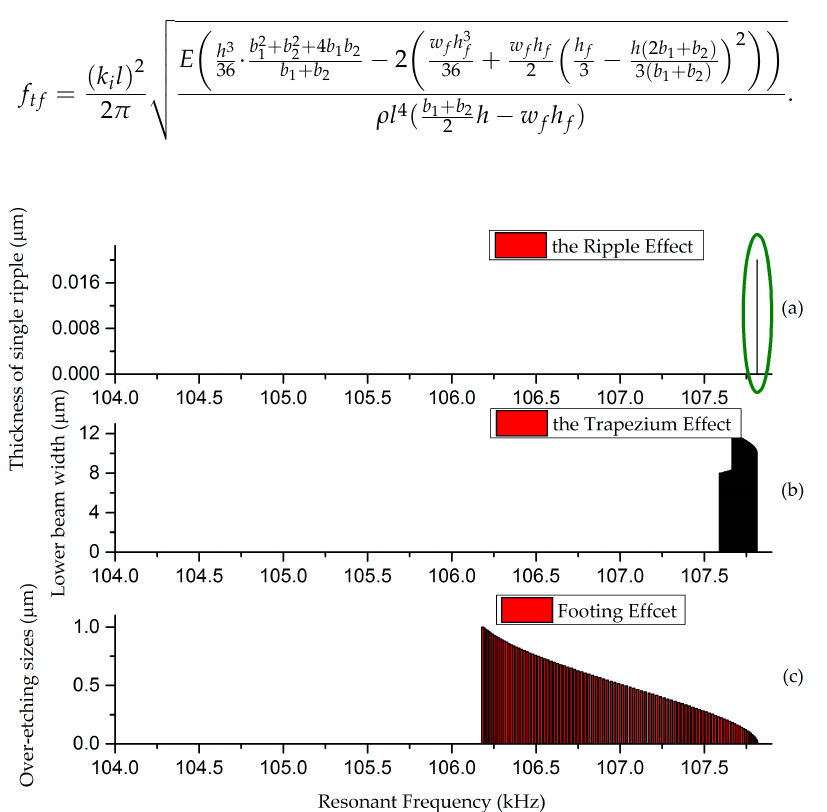
Figure 6. Sensitivity analysis on the effects influencing the resonant frequency of doubly-clamped beams. ( a ) is the result with considering the ripple effect. The narrow band circled by green equals the working part. ( b , c ) are cases for the trapezium effect and footing effect, where the cross section is treated as isosceles trapezoid in ( b ) and the over-etching sizes longitudinally and laterally are equal in ( c ).